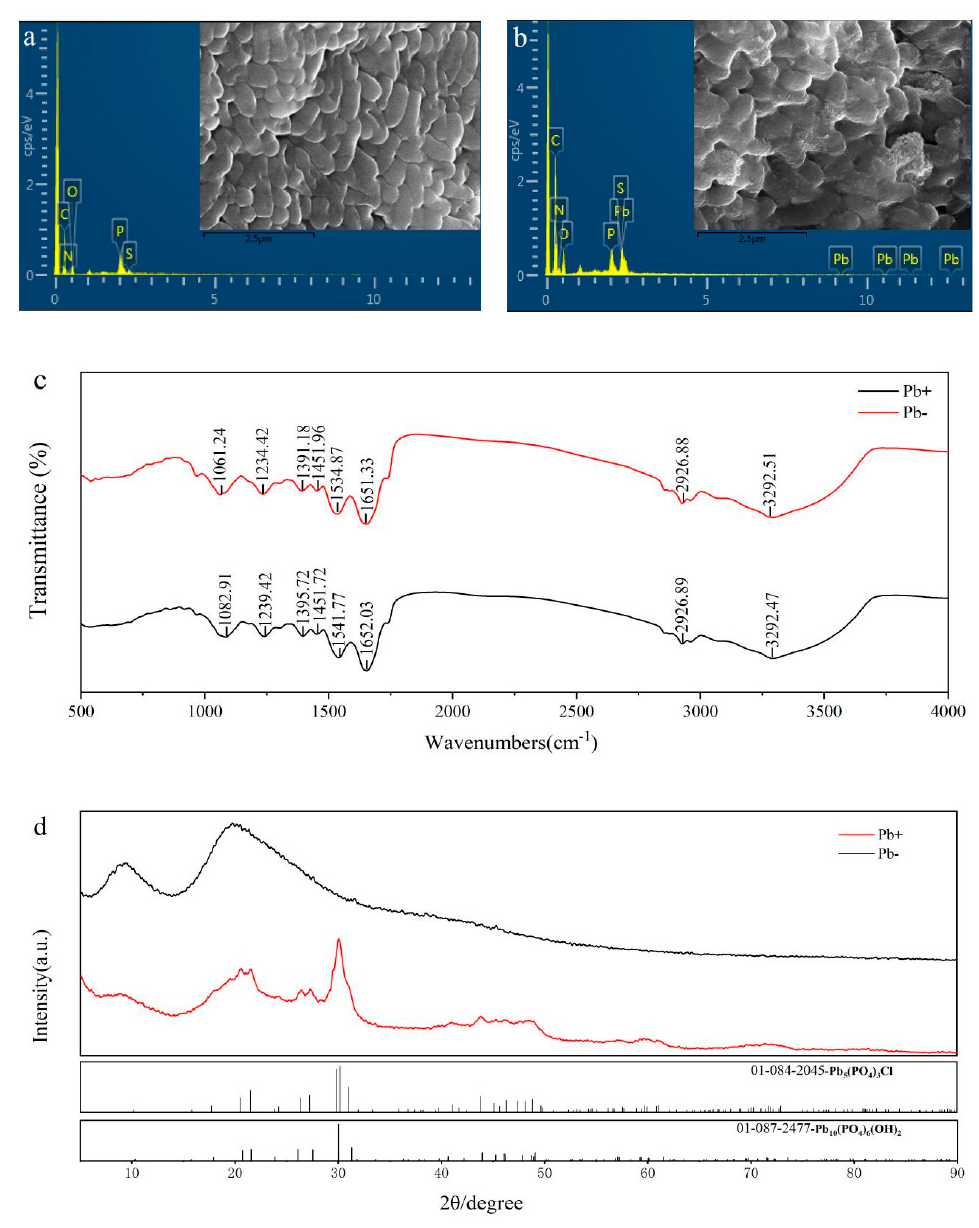
Figure 5. ( a ) and ( b ) were SEM–EDS spectra of PQ7 before and after treatment with lead ions, respectively; ( c ) FTIR and ( d ) XRD spectra of PQ7 before and after treatment with lead ions. The conditions were as follows: pH = 5, Pb(II) concentration = 200 mg/L, biomass = 1 g/L, contact time = 90 min.